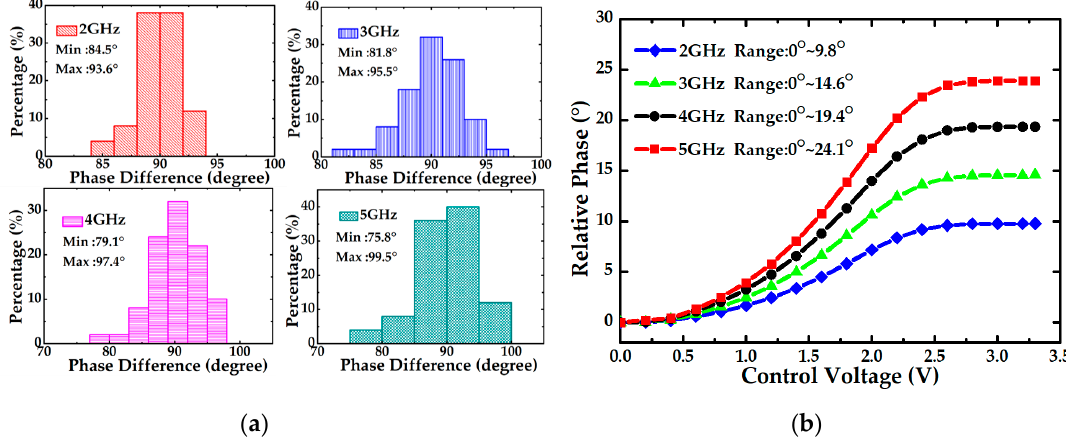
Figure 6. ( a ) Block schematic of the phase adjusting; ( b ) circuit implementation of the interpolator.